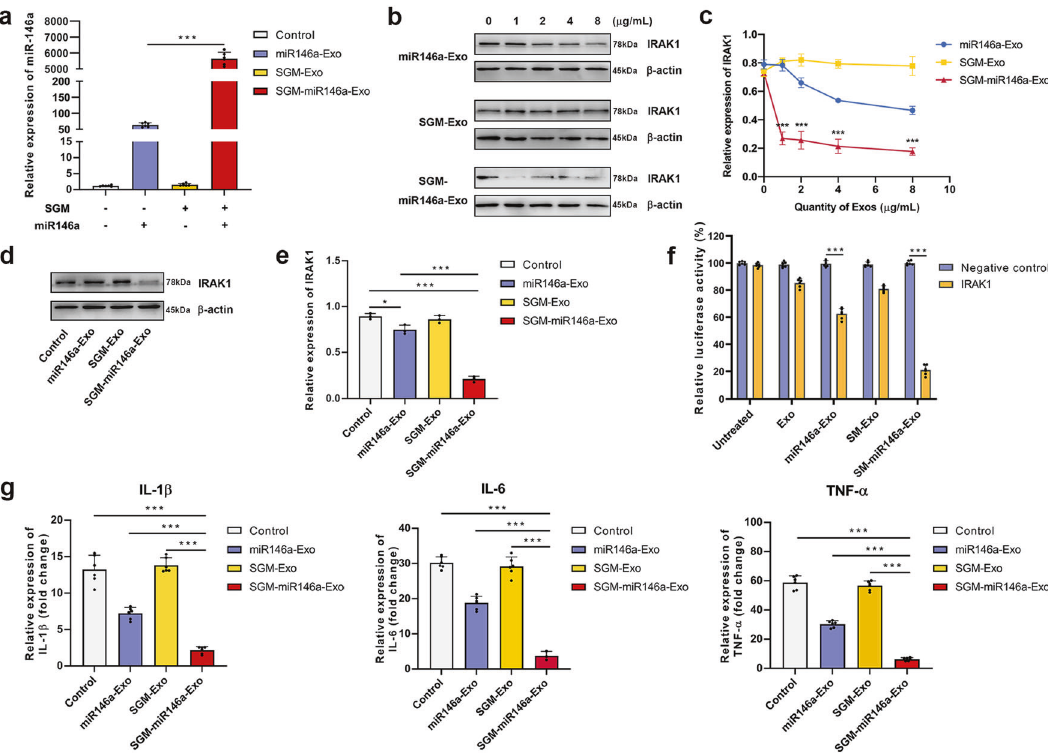
Fig. 4 Expression detection of miR146a in engineered exosomes and evaluation of miR146a silencing effects. a Expression of miR146a in engineered exosomes assessed by quantitative RT-PCR ( n = 6/group). b , c Western blot analysis of IRAK1 expression levels in HaCaT cells treated with gradient concentrations of engineered exosomes. d , e Western blot analysis of the inhibitory effect of 1 μ g/mL engineered exosomes on IRAK1 expression. f Dual-luciferase reporter assays of IRAK1 expression in each group. g ELISA analysis of in fl ammatory factors IL-1 β , IL-6, and TNF- α . ( n = 6/group). Data represent the mean ± S.D. of three different experiments (* p < 0.05, *** p <